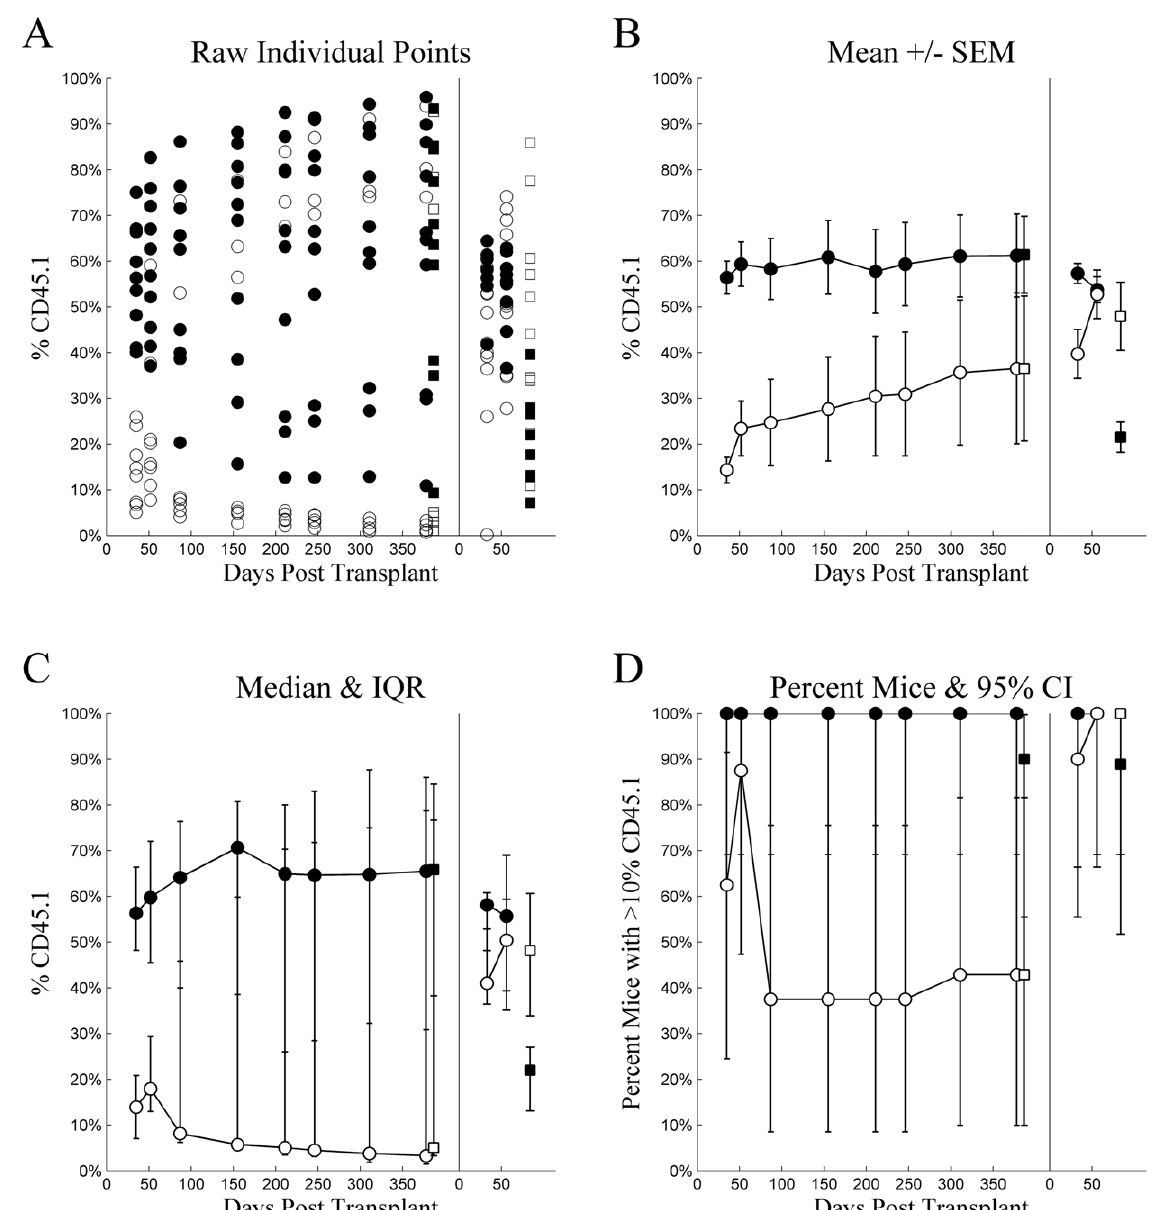
N N Figure 2. Experiment 1: intravenous injection. Chimerism (%CD45.1) (ordinate) plotted as a function of Days Post Transplant (abscissa), type of & : LT-HSC, #% : ST-HSC), and source ( # : whole blood, &% : whole bone marrow) for several different methods of summary: A) cells injected ( raw individual mouse percent CD45 cells that were CD45.1, B) mean 6 standard error of the mean, C) median with inter-quartile range, and D) percent of mice with greater than 10% of CD45 cells being CD45.1. For each tile, the data from the primary transplant is plotted on the left and secondary transplant on the right, separated by a vertical line at zero for the secondary transplant.